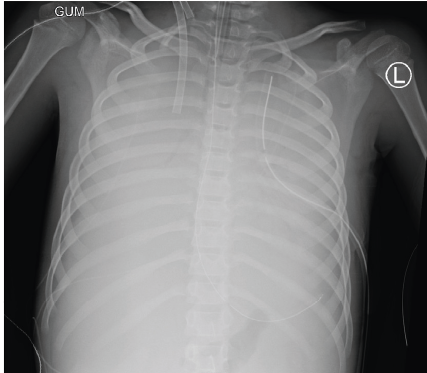
Figure 4: Chest radiograph showing progressive and complete opacification of bilateral lung